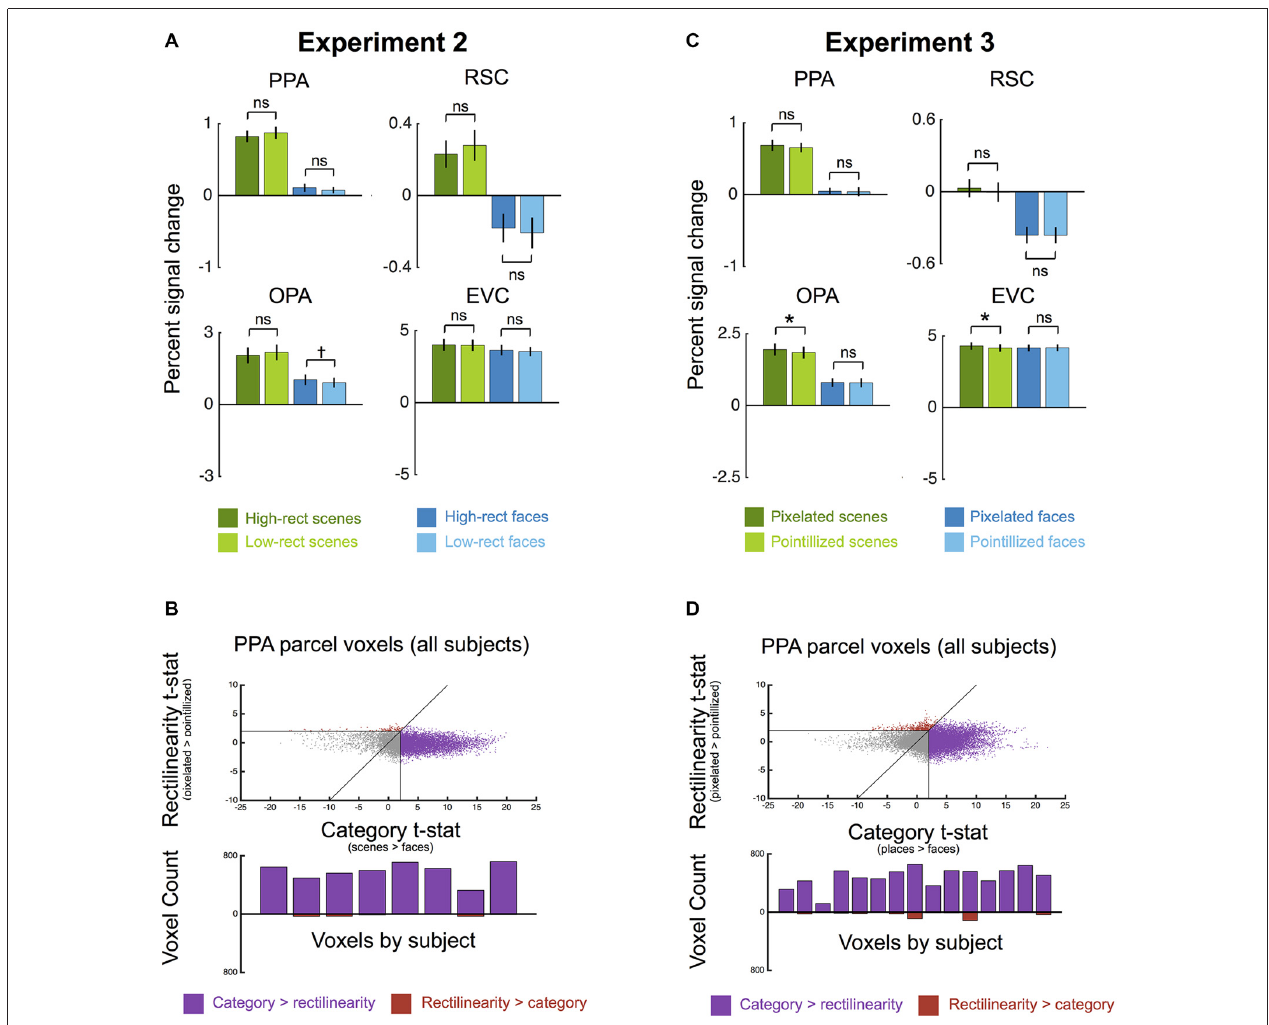
FIGURE 3 | Univariate results for Experiments 2 and 3. (A) Experiment 2 average percent signal change ( ± 1 SEM) to high-rectilinearity and low-rectilinearity scenes and faces in each ROI. No main effect of rectilinearity was observed in any ROI, although all ROIs showed a greater response to scenes than faces. (B) Experiment 2 comparison of rectilinearity-selectivity (high-rectilinearity > low-rectilinearity contrast t -statistic) and category-selectivity (scenes > faces contrast t -statistic) for all voxels in the group-defined PPA parcel for all participants (top row). Points that fall below the unity line are voxels with greater category-selectivity than rectilinearity-selectivity (shown in purple), and points that fall above the unity line are voxels with greater rectilinearity-selectivity than category-selectivity (show in red). Gray voxels were not significant ( p < 0.05, uncorrected) for either contrast. Few voxels exhibited greater rectilinearity-selectivity than scene-selectivity. The bottom row shows a histogram of rectilinearity- and category-selective voxels in each participant. In all subjects, the number of category-selective voxels far exceeded the number of rectilinearity-selective voxels. (C) Experiment 3 average percent signal change ( ± 1 SEM) to pixilated (high-rectilinearity) and pointillized (low-rectilinearity) scenes and faces in each ROI. No main effect of rectilinearity was observed in any ROI, although all ROIs showed a greater response to scenes than faces. (D) Experiment 3 comparison of rectilinearity-selectivity (pixilated > pointillized contrast t -statistic) and category-selectivity (scenes > faces